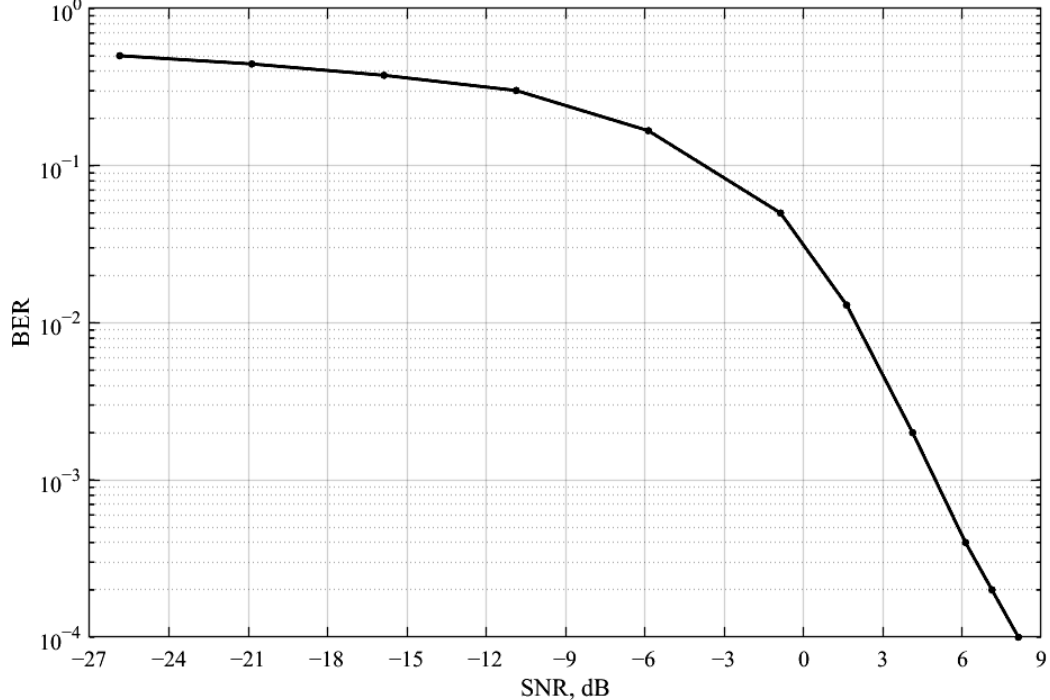
Figure 20. BER at different signal-to-noise power ratios.